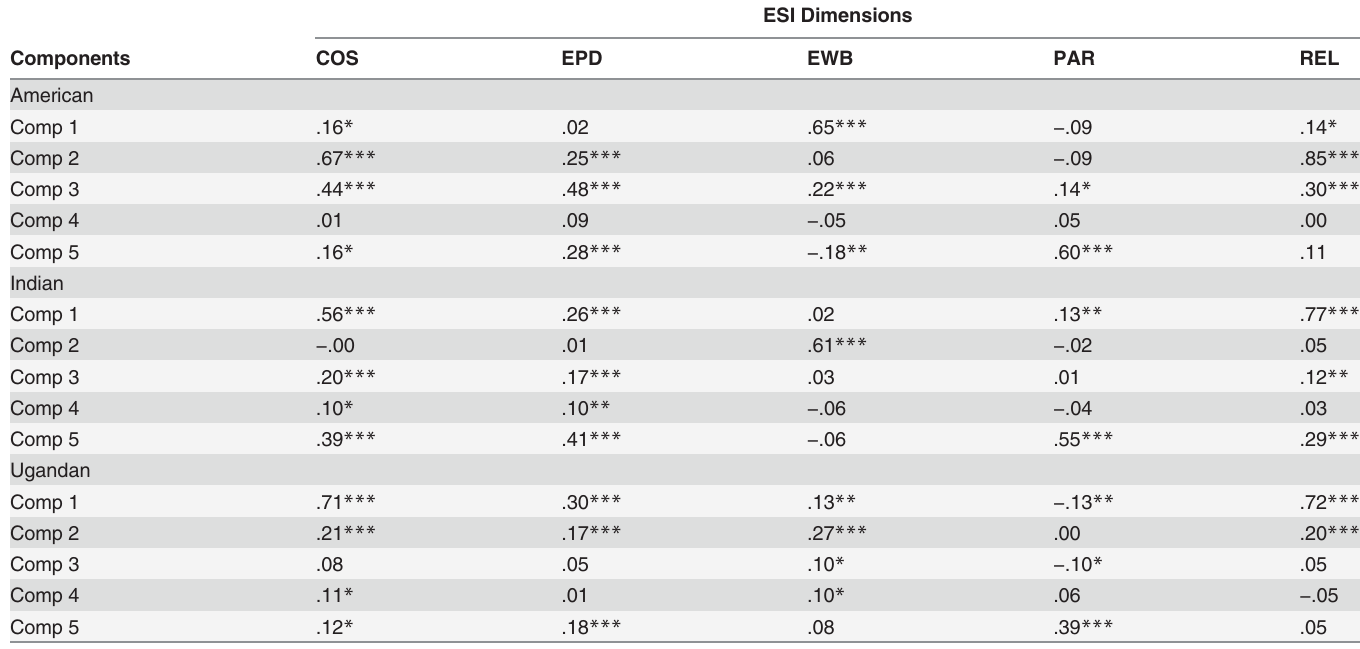
Table 18. Product-Moment Correlations Between Regression-Based SAL Component Scores and ESI-R